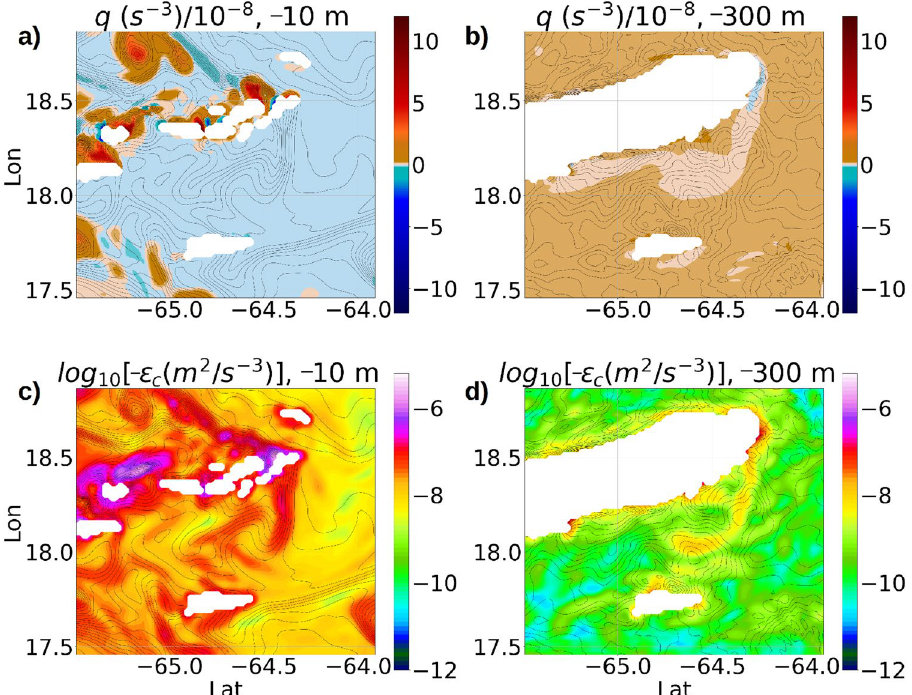
Figure 13. ( a ) Potential vorticity q at −10 m. ( b ) q at −300 m. ( c ) ǫ c at −10 m. ( d ) ǫ c at −300 m. All plots